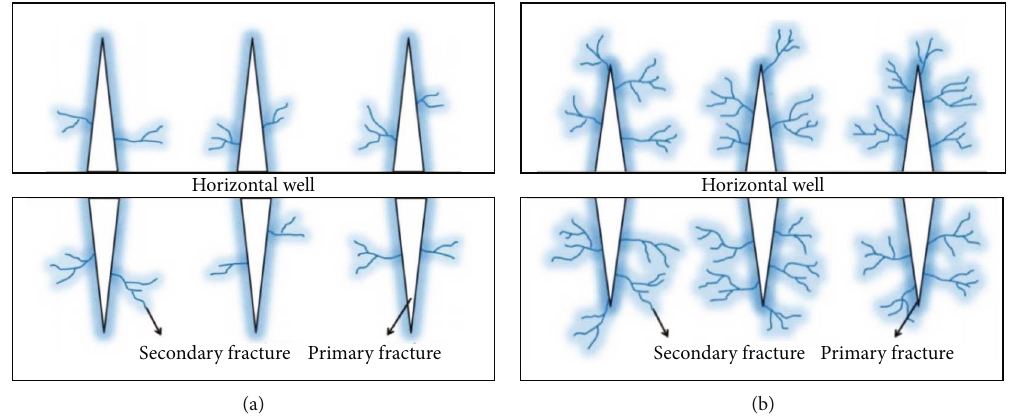
Figure 4: Comparison of simple and complex fracture network [32]: (a) simple fracture network and (b) complex fracture network.